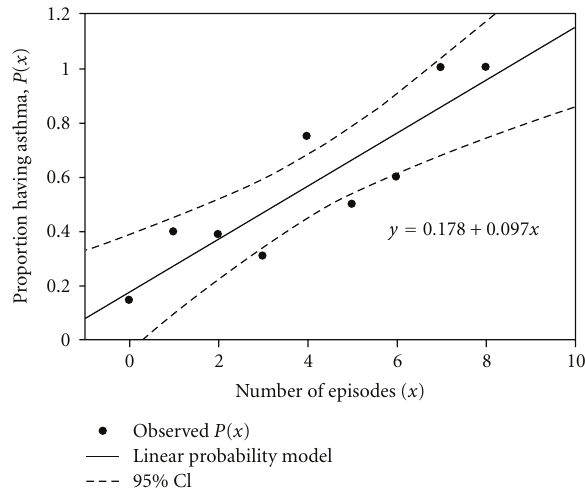
Figure 1: Prevalence of physician-diagnosed asthma and ACS episodes. The proportion of SCD patients having physician diag- nosed asthma was plotted against the number of episodes of ACS in children with SCD. SCD: sickle cell disease, ACS: acute chest syndrome, reproduced with permission from